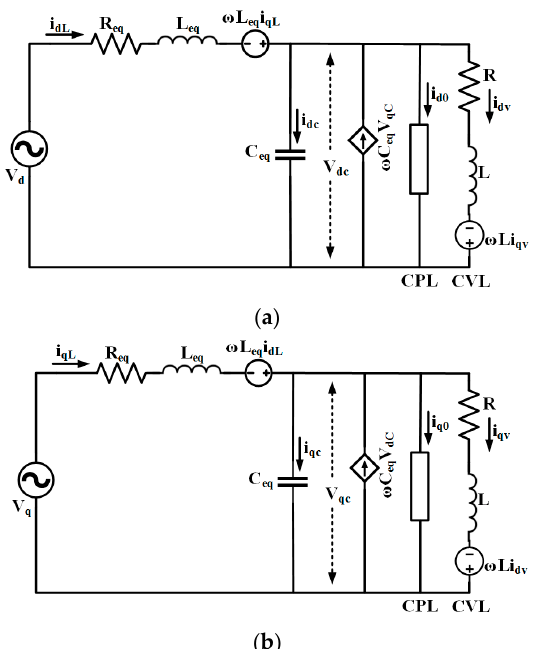
Figure 3. d-q axis model of a microgrid system. ( a ) d-axis model of a microgrid; ( b ) q-axis model of a microgrid.